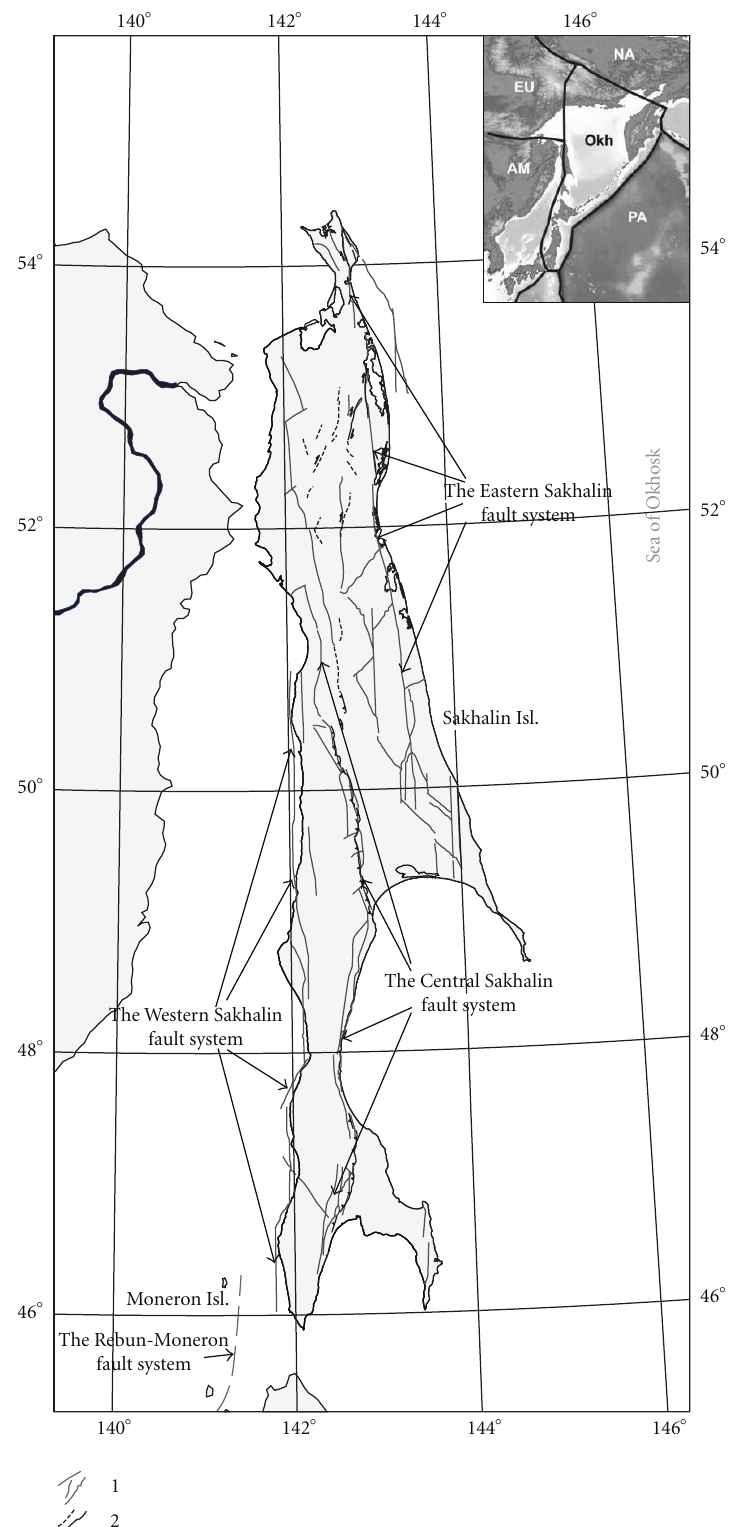
Figure 3: Active faults of the Sakhalin region. Insert—regional scheme of plate boundaries in the model NUVEL-1A and its modifications [14]. NA—North American, EU—Eurasian, PA—Pacific, OKH—Okhotsk